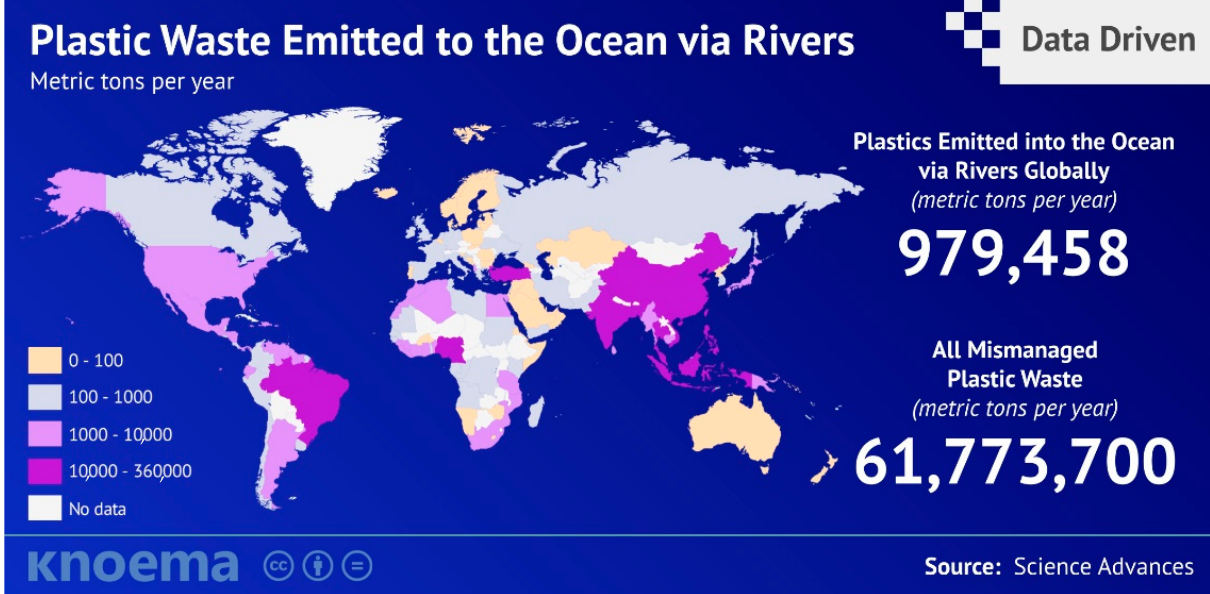
Figure 1. Plastic waste emitted into the oceans via rivers in tons per annum [12].